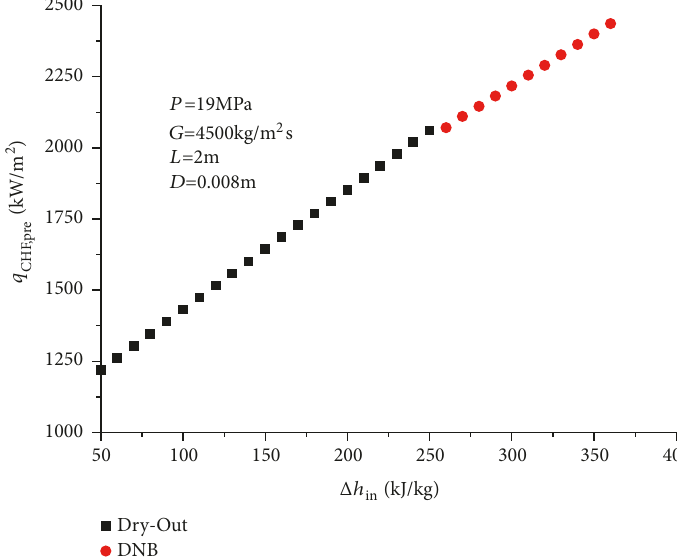
Figure 9: Continuous variation of CHF with inlet subcooled enthalpy.